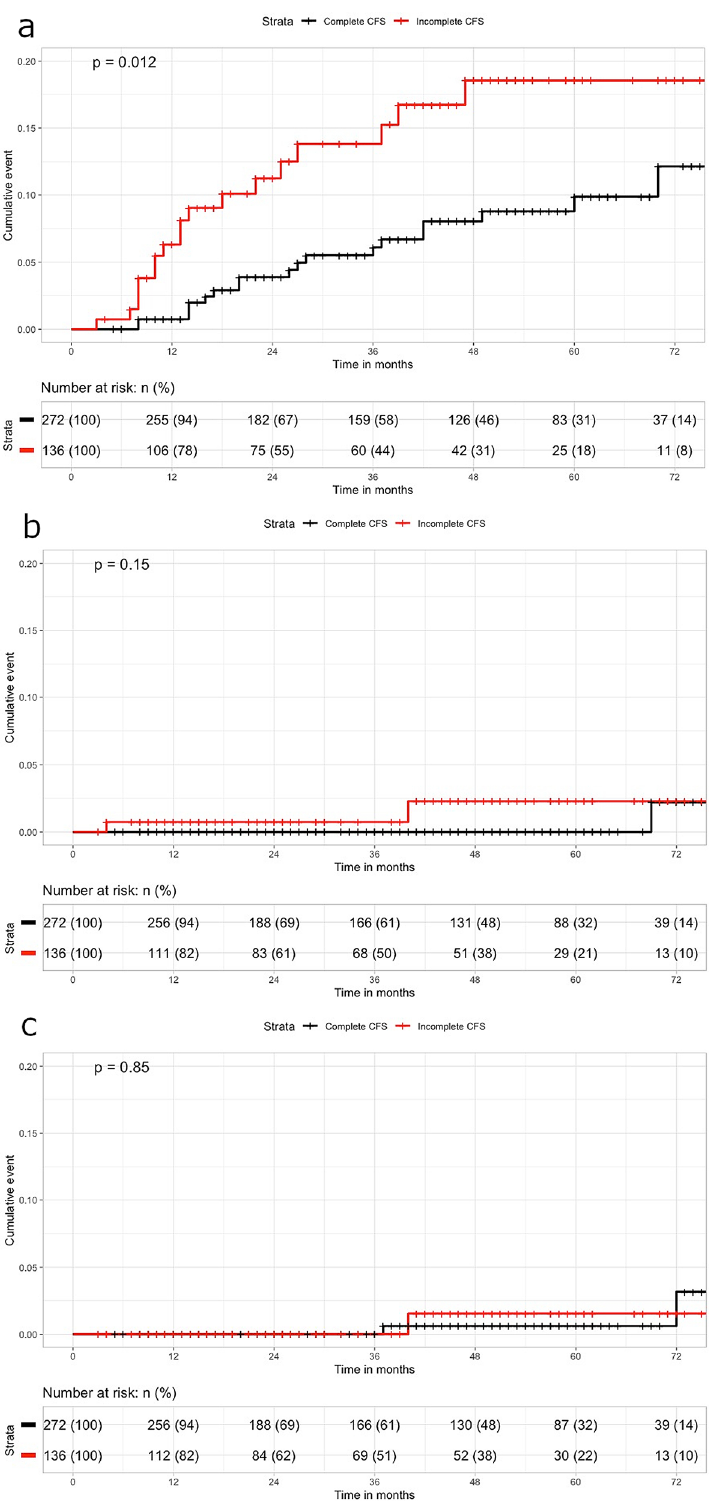
Figure 3. Comparison of cumulative risk after index surgery for detection of advanced adenoma ( a ), carcinoma ( b ), additional operation ( c ) in the matched